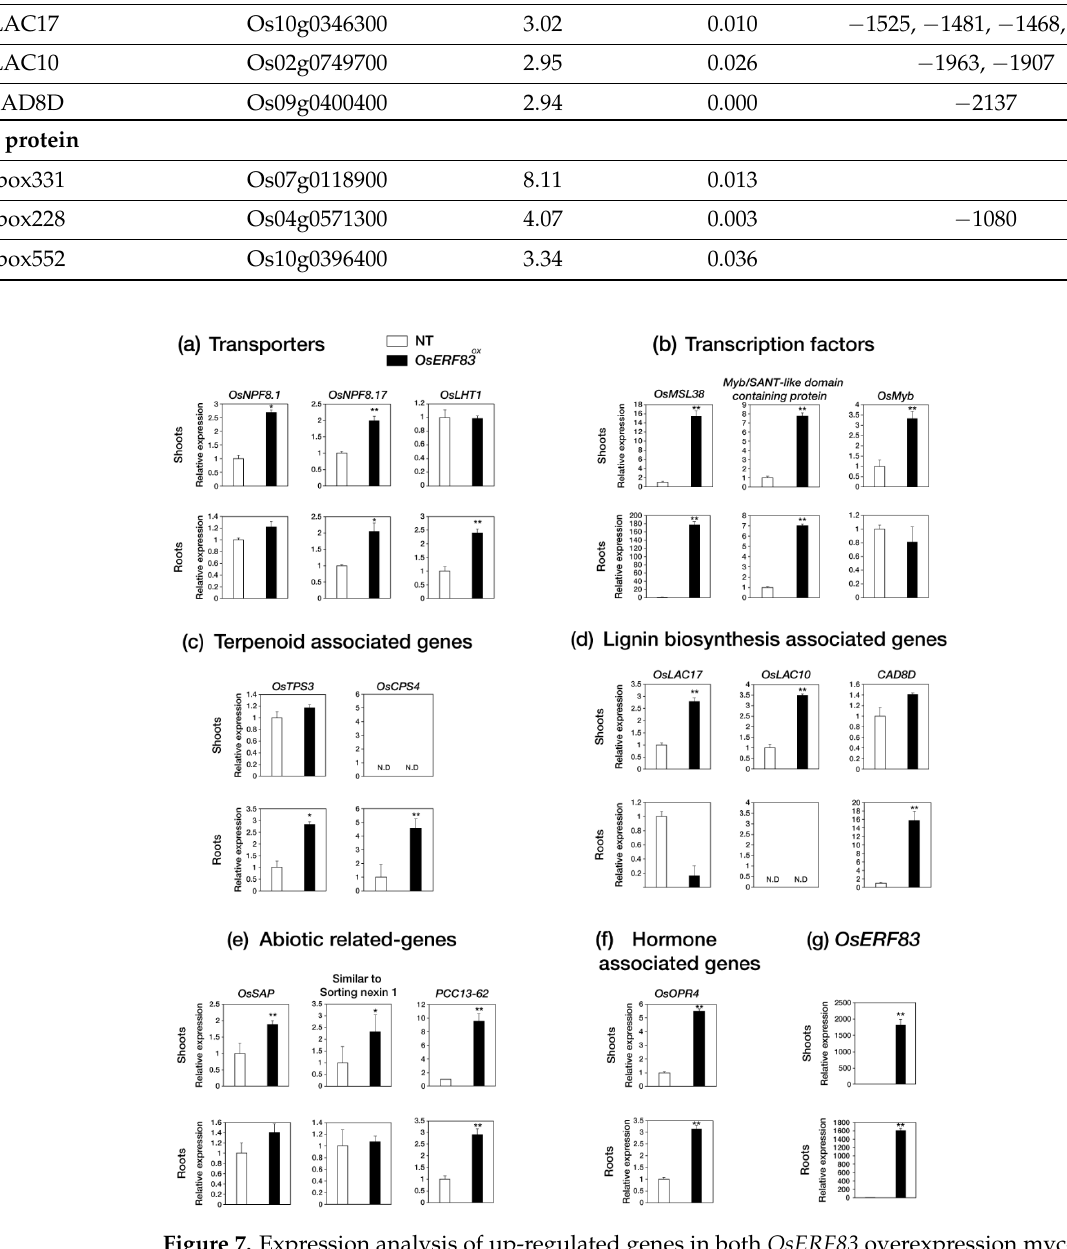
Figure 7. Expression analysis of up-regulated genes in both OsERF83 overexpression myc-tagged transgenic ( OsERF83-MYC OX ) plants and drought-treated samples. ( a ) Relative expression levels of transporter genes ( b ), transcription factors ( c ), terpenoid-associated genes ( d ), lignin biosynthesis- associated genes ( e ), abiotic stress-related genes, ( f ) and hormone associated genes, (g) qRT-PCR analysis of OsERF83 expression in 3-week-old OsERF83 OX (line 1). The white bar is the expression value in NT plants, and the black bar is the expression value in OsERF83 OX plants. OsUbi ( Ubiquitin1 ; Os06g0681400) expression was used as an internal control for normalization. Error bars indicated the standard deviation based on three technical replicates. Asterisks indicate significant enriched GO terms (* p < 0.01, p <